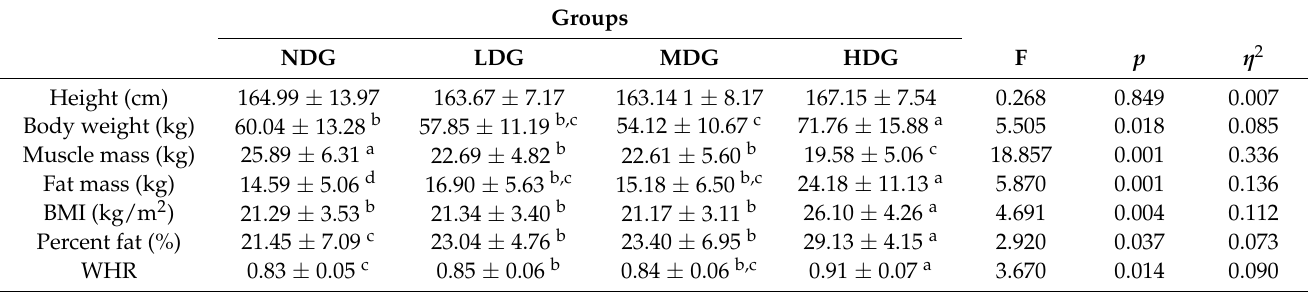
Table 2. Comparative results of body composition among the four groups.